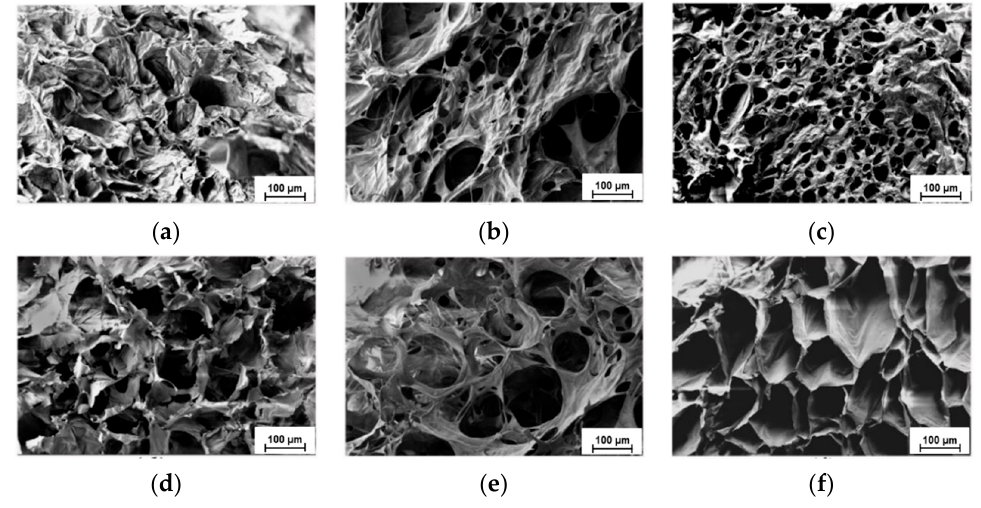
Figure 6. Scanning Electron Microscopy (SEM) micrographs of HYDRO ( a – c ) and HYDRO-Bes ( d – f ) crosslinked for 24 h ( a , d ), 72 h ( b , e ), and 96 h ( c , f ).